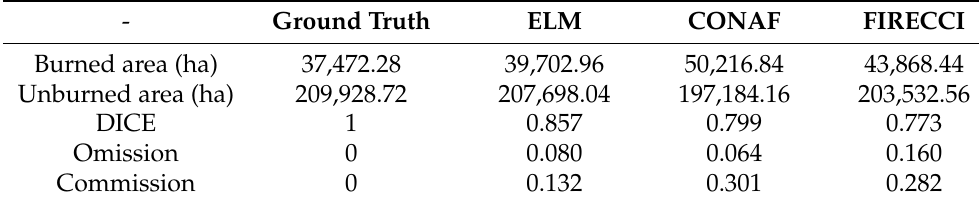
Table 7. ELM–CONAF–FIRECCI